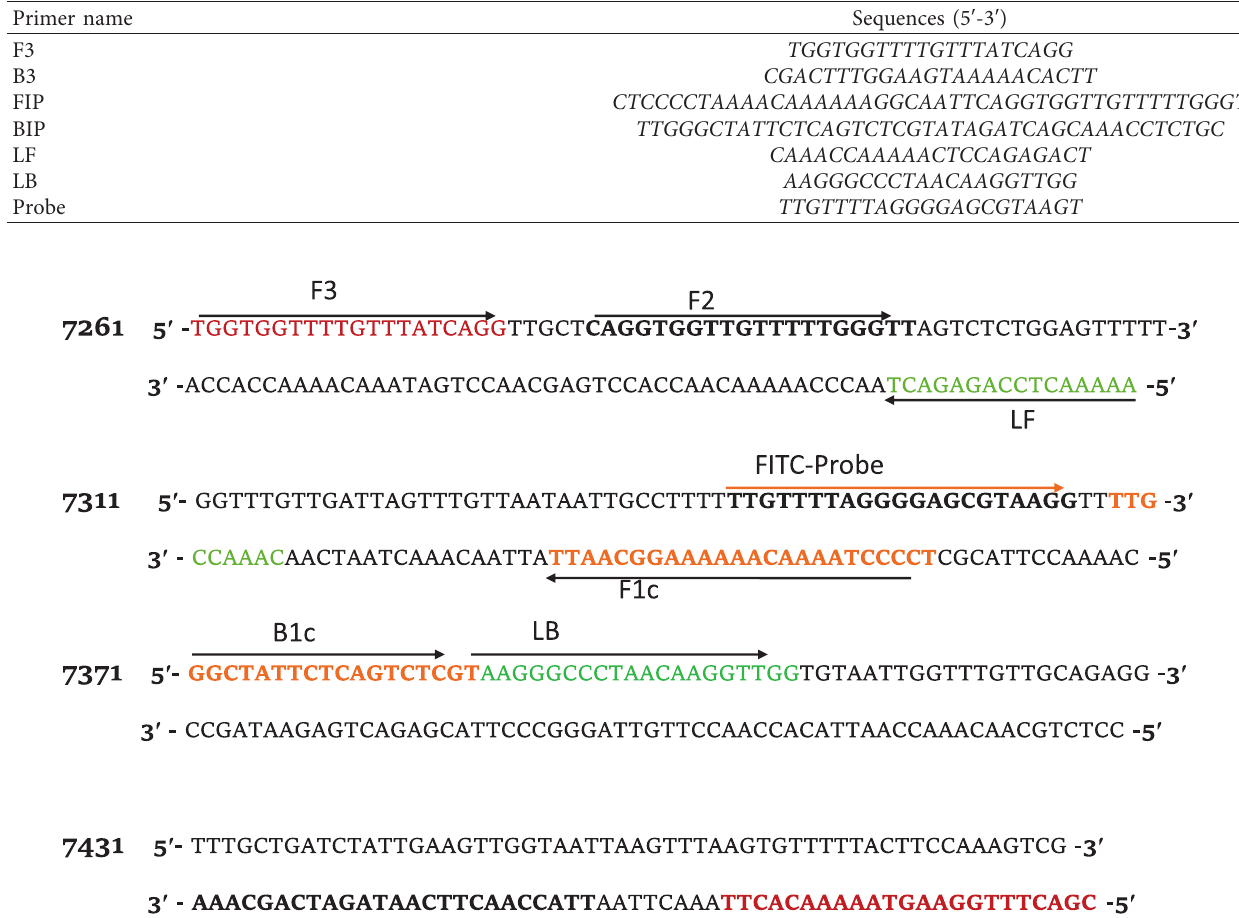
Table 1: LAMP primers and probe used in this study.